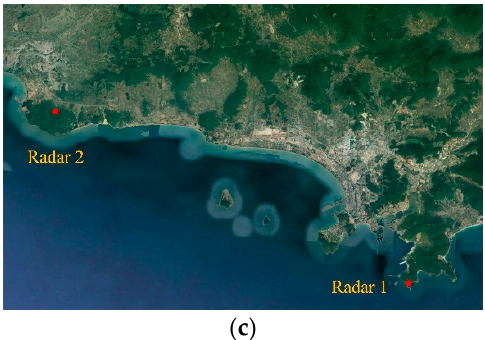
Figure 3. The radar image of two real scenarios: ( a ) video data of Radar 1; ( b ) video data of Radar 2; and ( c ) location of the two radars.